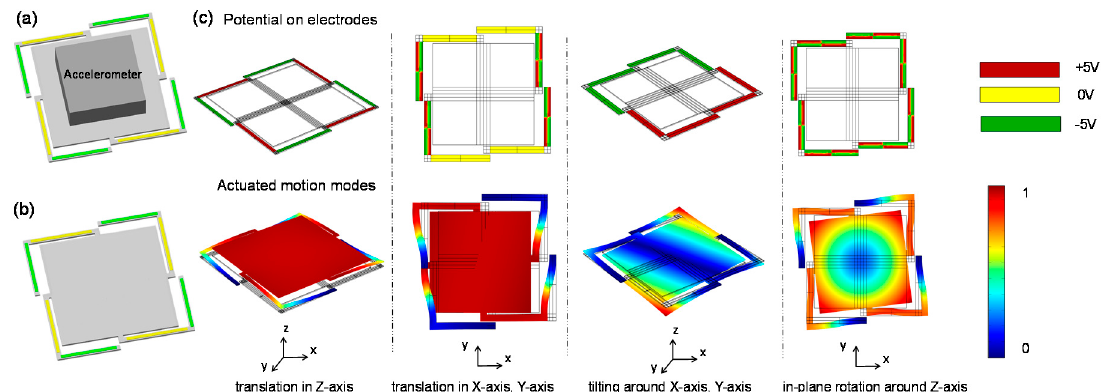
Figure 2. Piezoelectric micro-vibrator with simulated 6-DOF motion capability. ( a ) A schematic of the vibratory platform with an accelerometer payload; ( b ) A finite element method simulation model; ( c ) FEM simulation results for micro-vibrator when the stage is excited for 6-DOF motion.